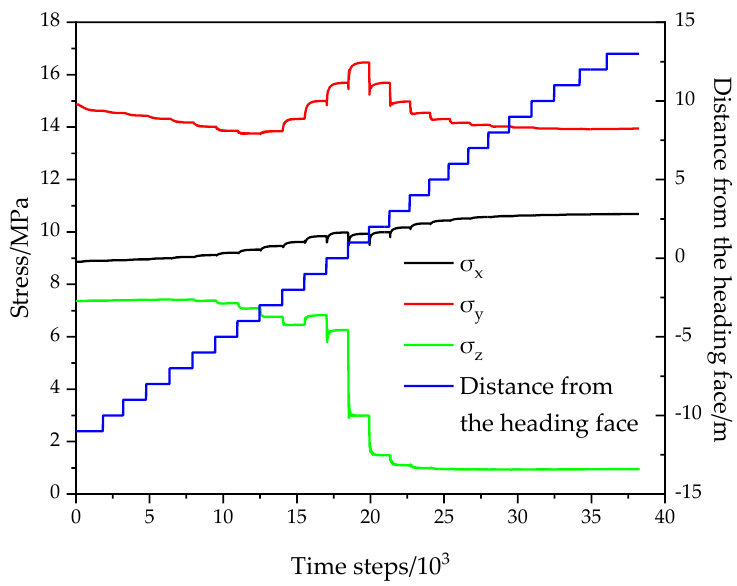
Figure 8. Three-way stress change curve of roof in heading face.